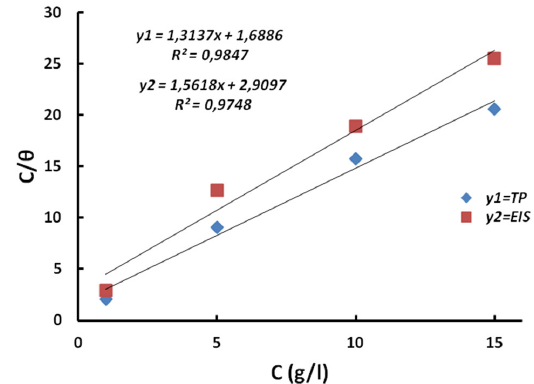
Figure 11. Langmuir adsorption plot for Al-2007 alloy immersed in a 3.5% NaCl medium containing different concentrations of mad honey obtained by using surface coverage values calculated from Tafel polarisation and EIS